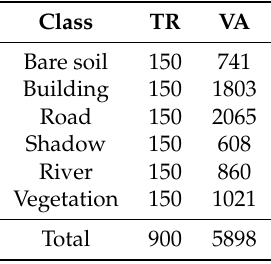
Table 2. Beijing scene: classes, training and validation